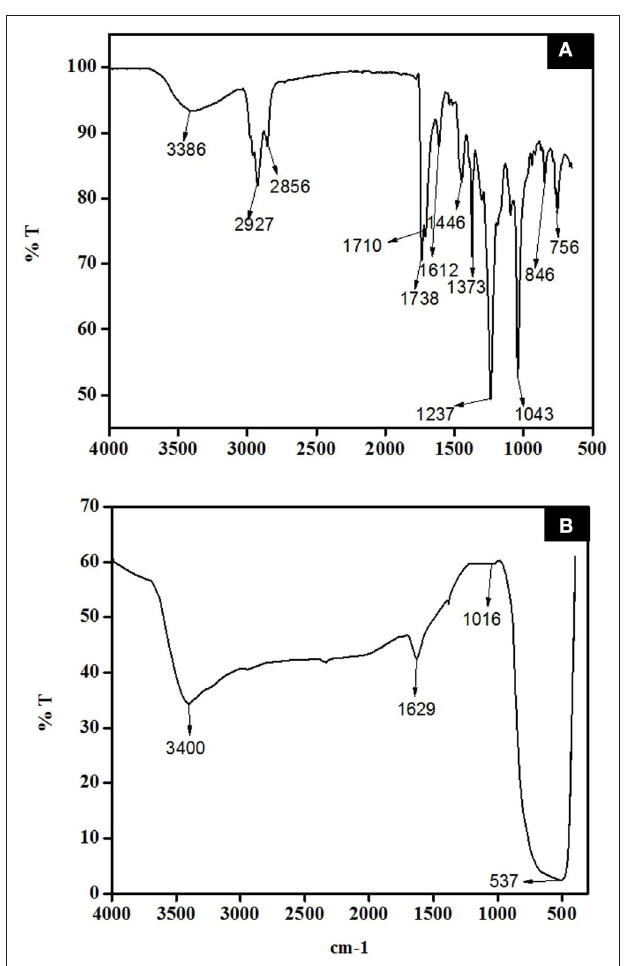
FIGURE 13 | FTIR spectra of ( A ) D. pinnata crude extract and (B) synthesized TiO 2 NPs.